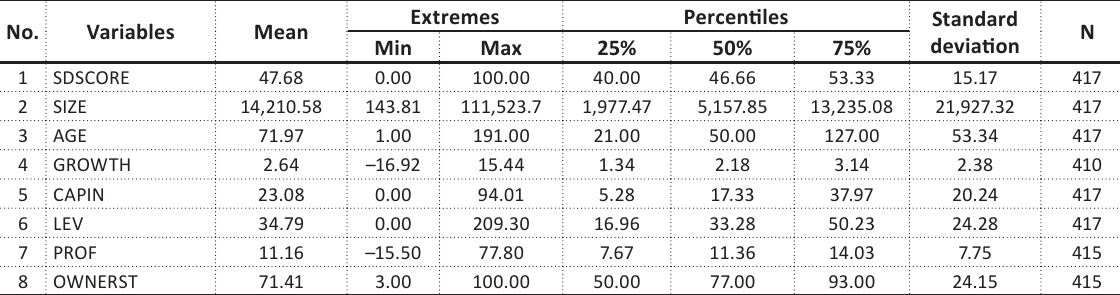
Table 2. Descriptive statistics of metric variables No.